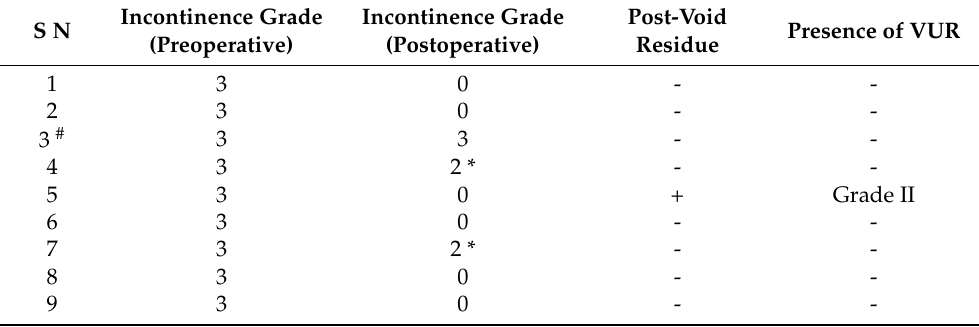
Table 2. Incontinence and functional status at